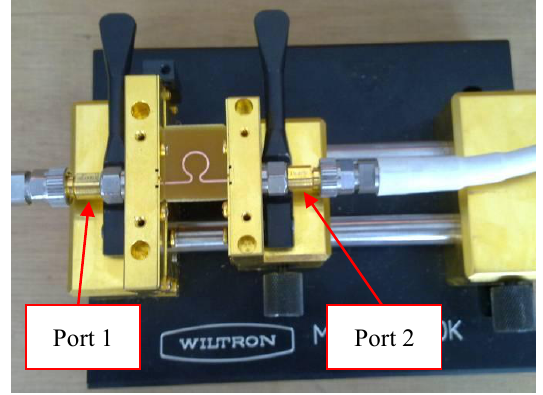
Figure 5: Universal test fixture used for the IUT characterization